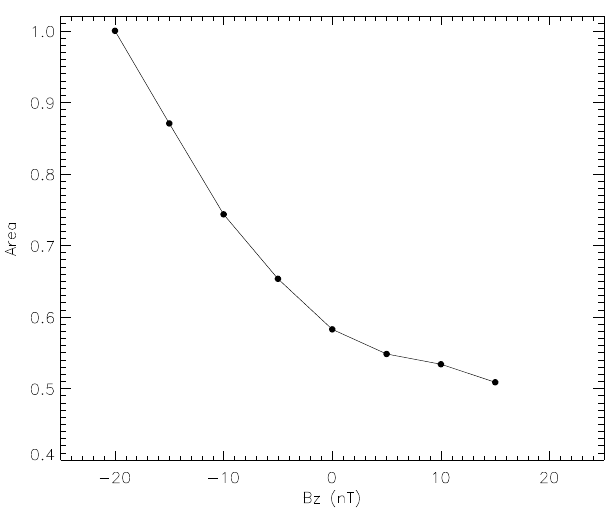
Figure 4. The CRW area as a function of the z component of IMF, all other parameters are the same as that at the quiet time 6 July 2001, 12:00UT. The y axis has been normalized by the max- imum area of CRW during this period.